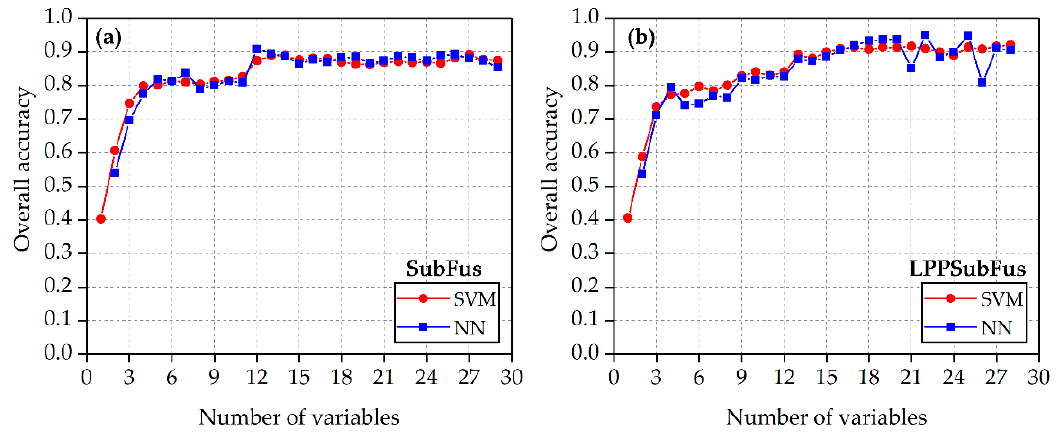
Figure 7. Overall accuracy curves varying with the feature number using support vector machine (SVM) and neural network (NN) algorithms: ( a ) overall accuracy using subspace fusion (SubFus) and ( b ) overall accuracy using locality preservation projection and subspace fusion (LPPSubFus).